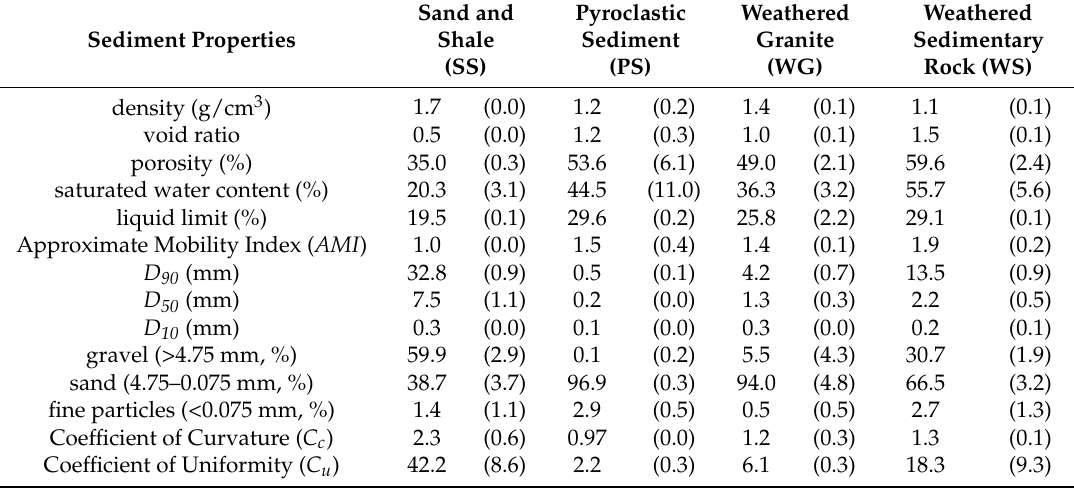
Table 1. Summary of sediment properties for the four sediment types. Values in parentheses indicate standard